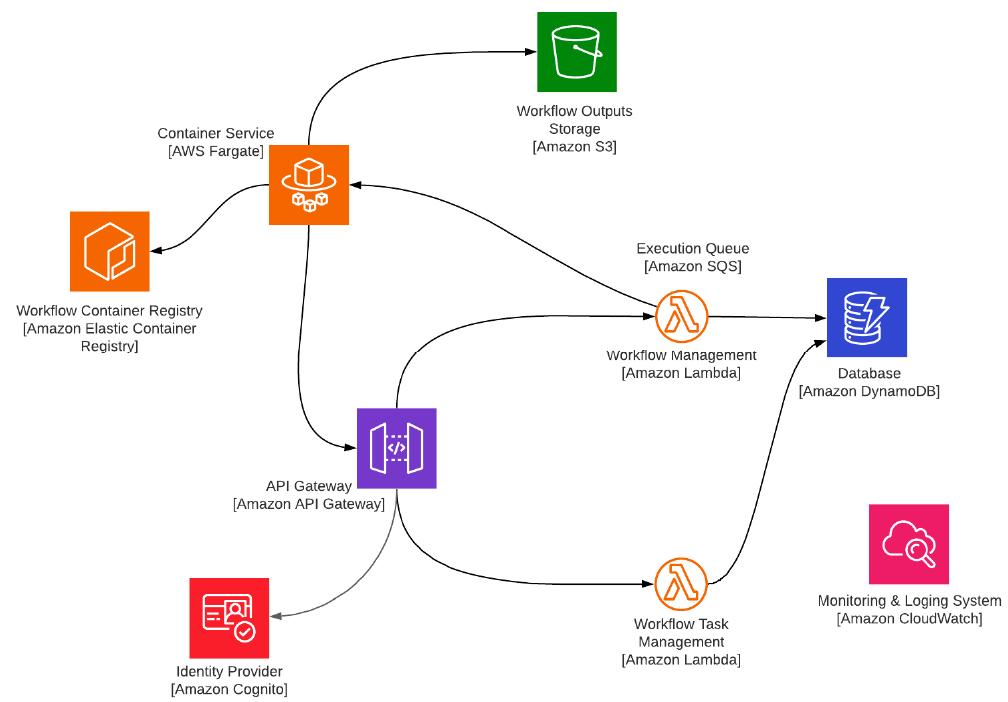
Figure 12. The public cloud deployment of the proposed system architecture with serverless services on